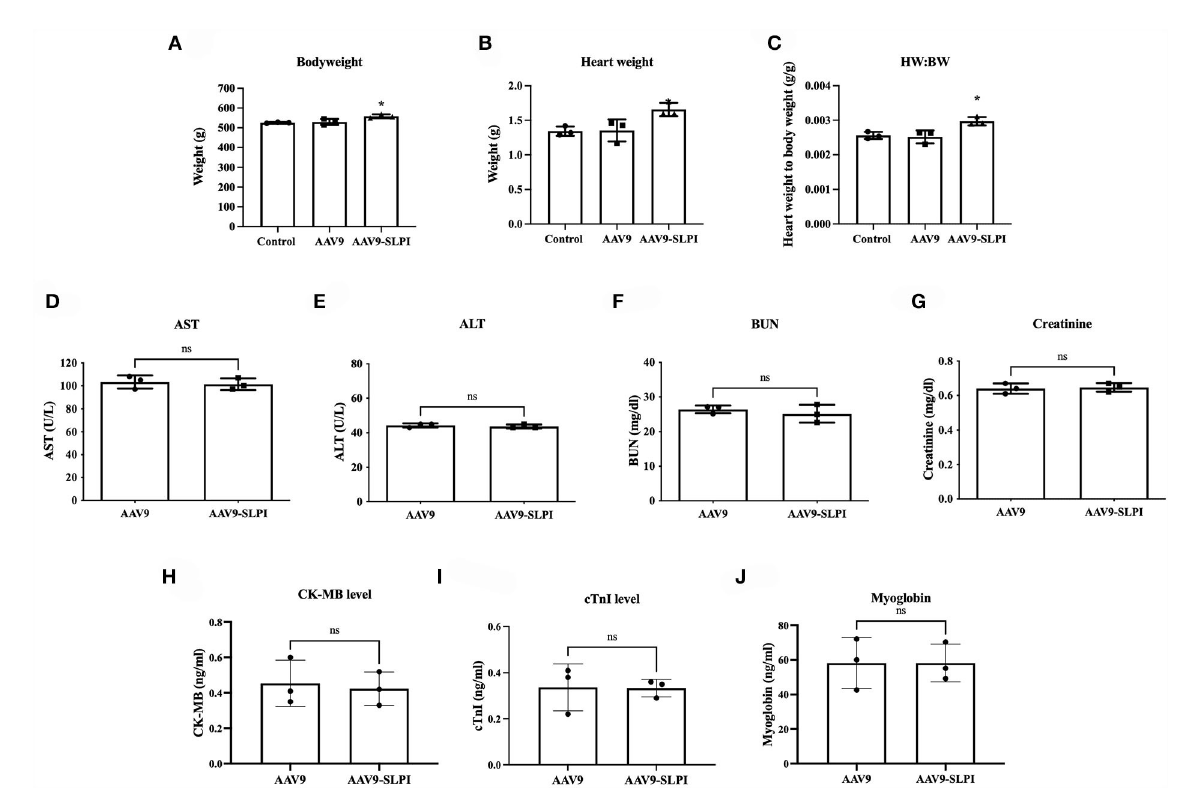
FIGURE1 Determination of body weight of experimental animal after viral treatment in I/R injury (A) , heart weight (B) , heart weight-to-body weight ratio (C) . Determination of serum toxicity biomarkers after adeno-associated viral particles injection including AST (D) , ALT (E) , BUN (F) , and creatinine (G) . Determination of serum myocardium injury biomarkers after AAV9 injection including CK-MB (H) , cTnI (I) , and myoglobin (J) (* p < 0.05 vs. control).